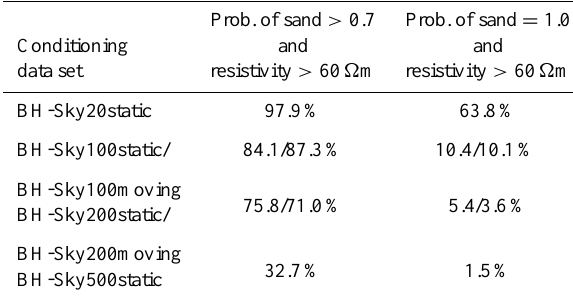
Table 2. Proportion of high-probability sand cells (resistiv- ity > 60 (cid:127) m) that are simulated with corresponding sand probabili- ties ( > 70%) or fully deterministic (probability = 1.0) for six con- ditioning data sets based on 25